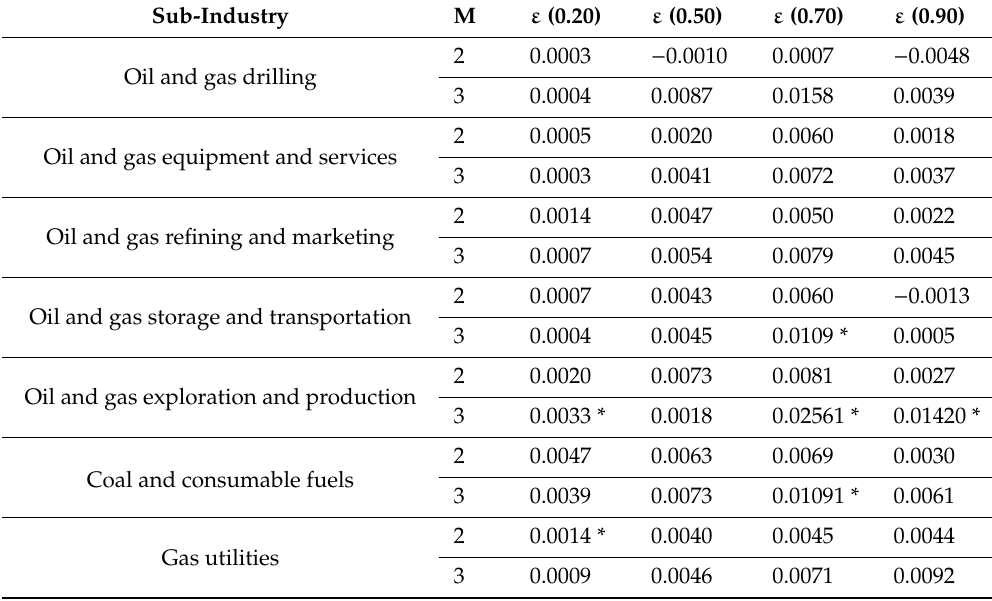
Table 6. Brock–Dechert–Scheinkman (BDS) test of